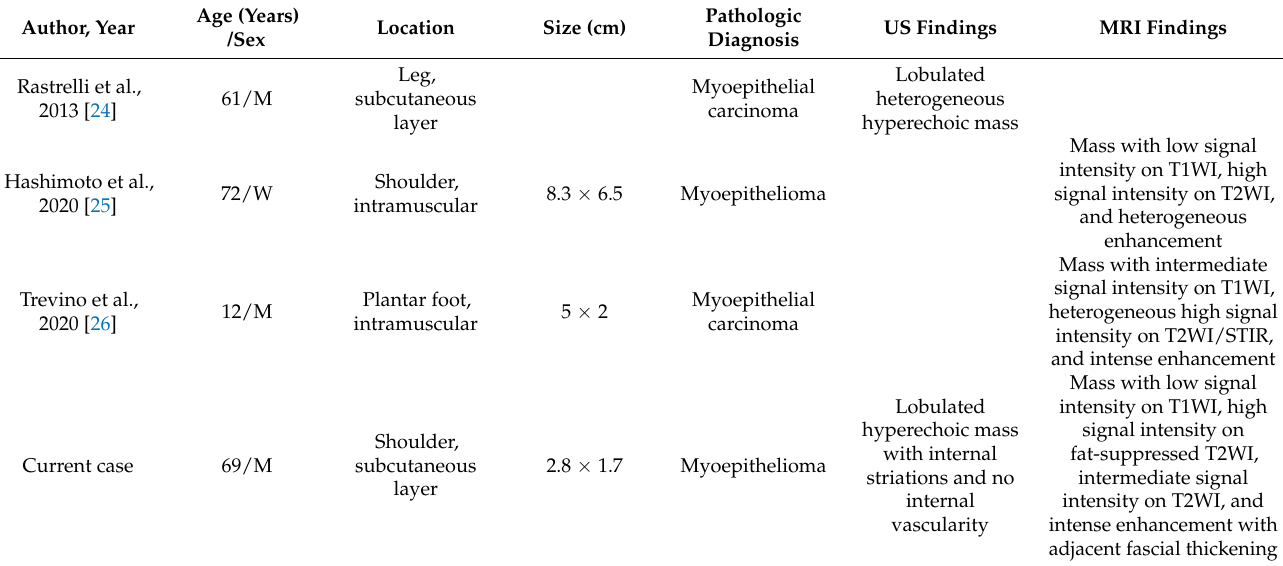
Table 1. Imaging features of soft tissue myoepithelial